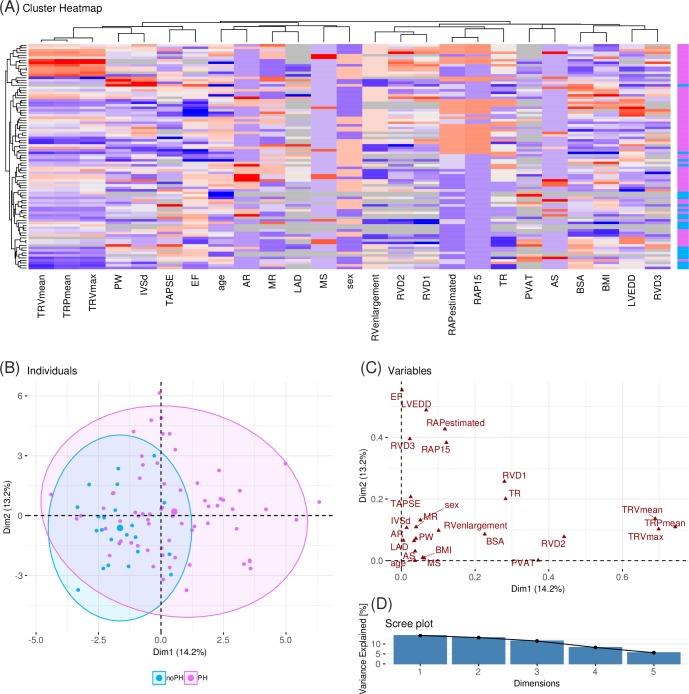
Data overview.(A) Heatmap of the 27 variables (columns) across the 90 patients (rows). The variables are studentized. Both patients and variables are re-ordered by hierarchical clustering. The color bar at the right shows patients with PH (pink) and without PH (blue). (B)-(D) Results from a factor analysis for mixed data (FAMD). (B) The first two dimensions explaining the largest parts of the variance in the data. Each dot represents one patient, where patients with PH are shown in pink, patients without confirmed PH are shown in blue. (C) Contribution of each of the variables to the first two dimensions of the FAMD. (D) Percentage of variance for the first five dimensions in the FAMD.